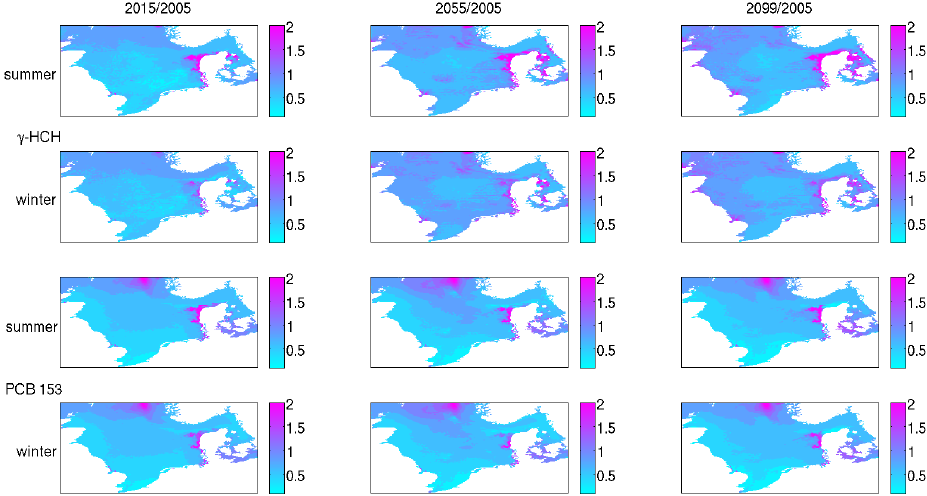
Figure 9. Distributions of concentration ratios in sediment, 2015/2005, 2055/2005 and 2099/2005, from left to right, respectively, for γ -HCH in winter (top) and summer (second row), and PCB 153 in winter (third row) and summer (bottom). Units are ngg − 1 dry